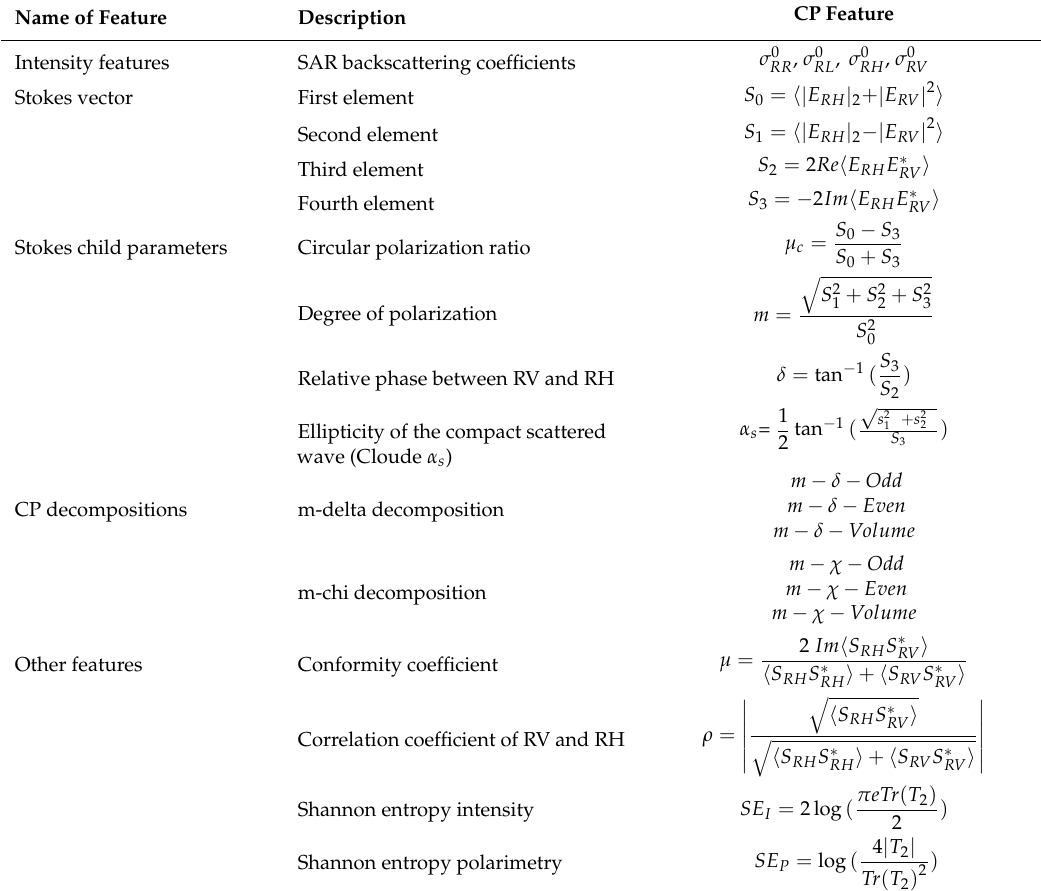
Table 3. An overview of the investigated CP SAR features in this